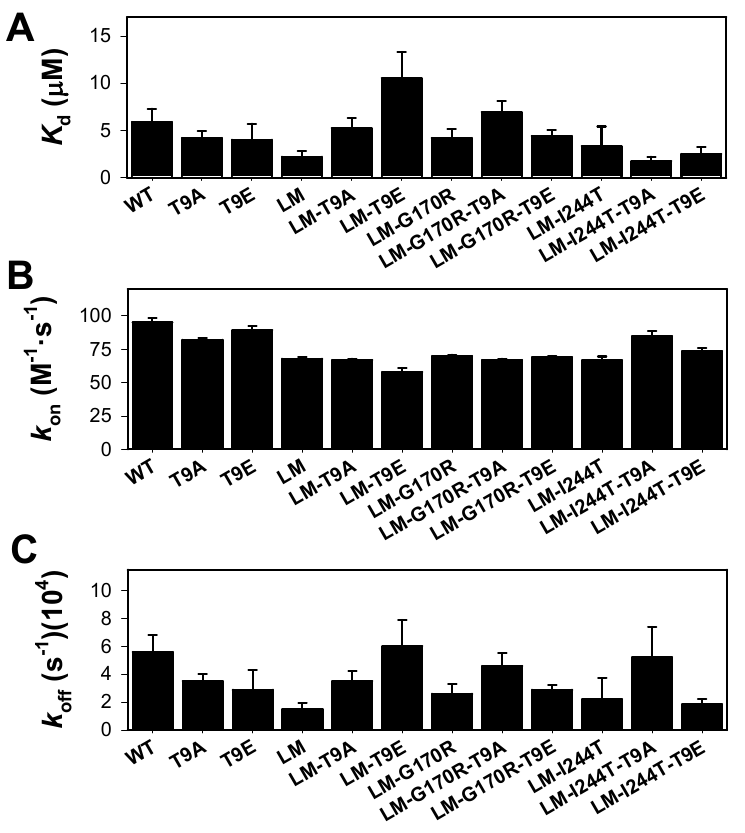
Figure 7. PLP binding to apo-AGT variants (WT, LM, LM-G170R, and LM-I244T) in the absence or presence of the T9A or T9E mutations. ( A ) Apparent dissociation constants for PLP binding; ( B , C ) Association ( k on , panel B ) and dissociation ( k off , panel C ) rate constants for PLP binding. PLP binding was monitored by quenching of apo-AGT intrinsic fluorescence under pseudo-first order conditions ([PLP] > >[Apo-AGT]). Experiments were performed in HEPES-NaOH 20 mM, NaCl 200 mM, pH 7.4, and 25 ◦ C. Errors are those from fittings or from propagation for K d.